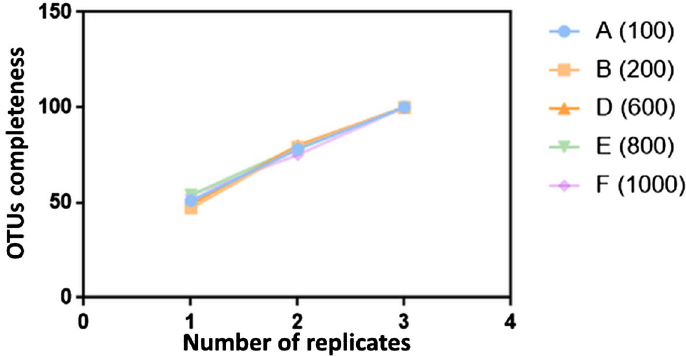
Figure 4. Relative increase in OTUs completeness with each added replication (a total of three) for different amounts of seed samples. [A = 100 seeds ( ), B = 200 seeds ( ), D = 600 seeds ( ), E = 800 seeds ( ) and F = 1000 seeds ( )].